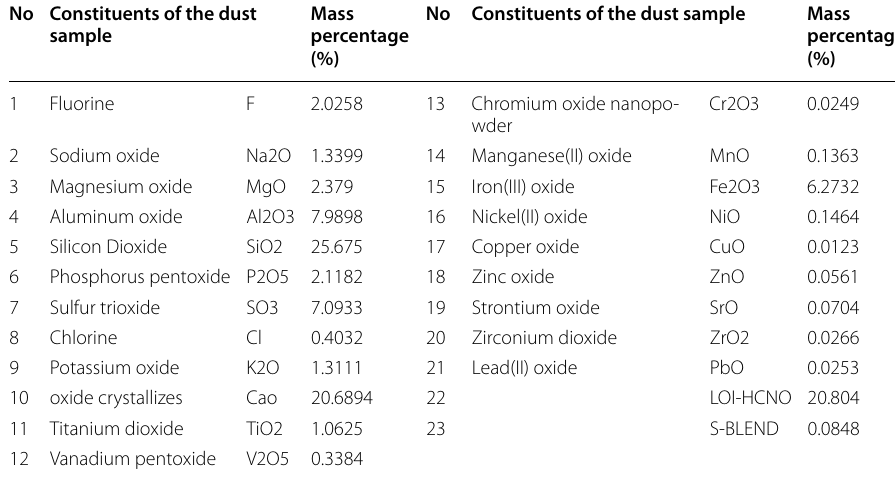
Table 2 Main constituents of the dust sample by XRF No Constituents of the dust